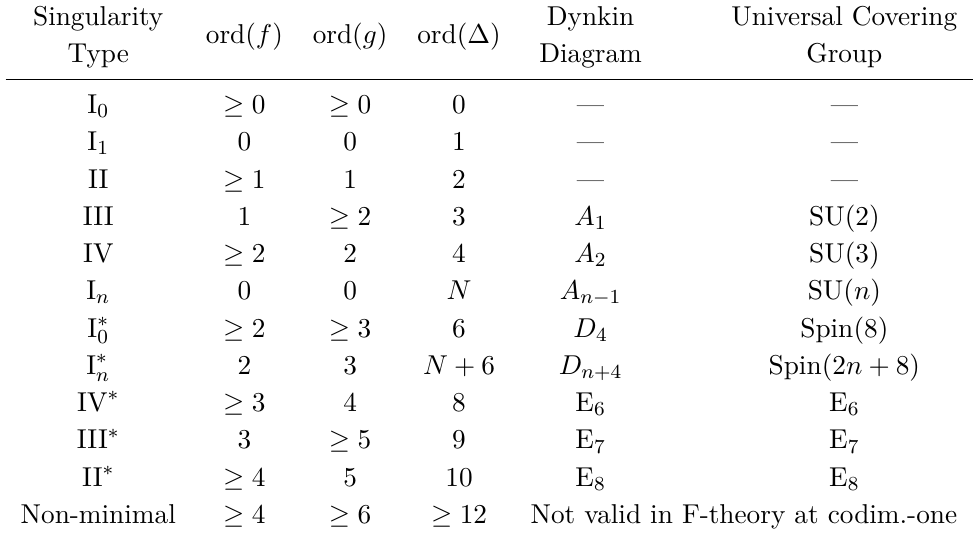
Not valid in F-theory at codim.-one Table 4. The Kodaira classification of codimension-one singular fibers. The orders of vanishing of f, g, ∆ at the singular locus in the base are given. The Dynkin diagram entry gives the intersection pattern of the exceptional P 1 s introduced by the resolution procedure; these are potentially subject to Tate monodromy, though we will only consider ADE cases here. The gauge algebra entries list the universal cover of the gauge algebras associated with the given singularity type; which gauge algebra is actually realized by a given singularity is determined via the Tate split conditions mentioned in the text. Note that the final row lists non-minimal singularities, which cannot be resolved crepantly such that the fibration remains